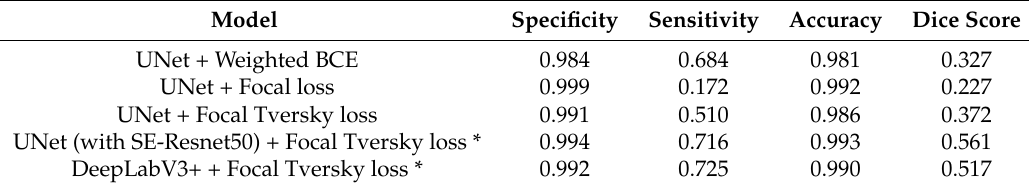
Table 2. The impact of different loss functions and pre-trained models on the Image-Level models. We evaluate on our dataset from Kangbuk Samsung